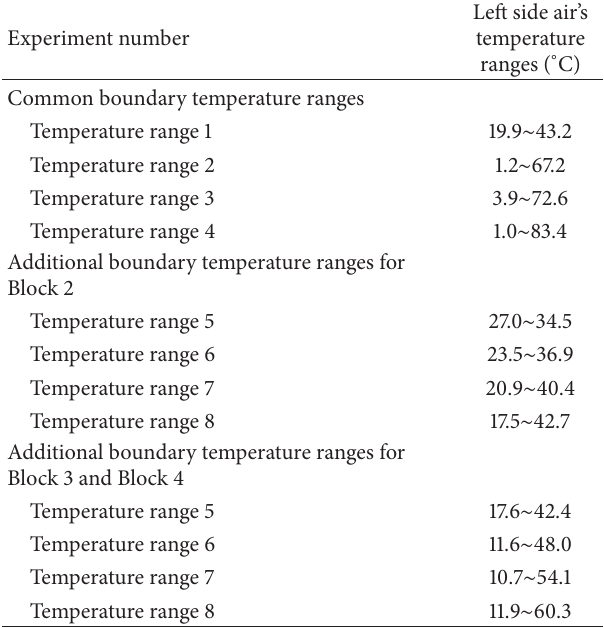
Table 2: Boundary temperature ranges of each